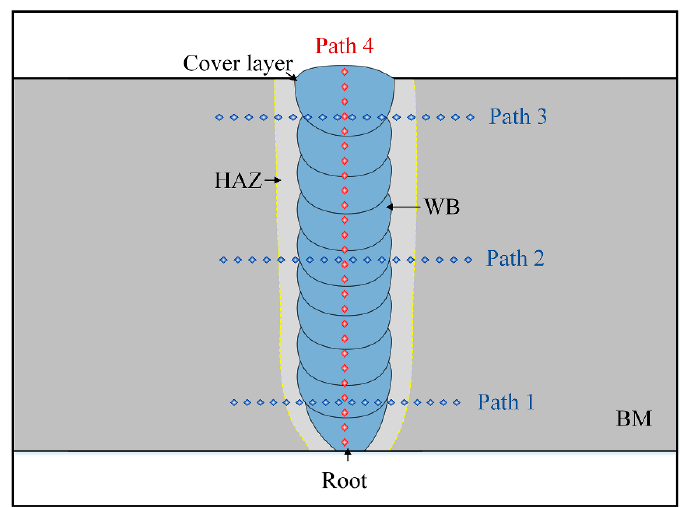
Figure 11. The Vickers hardness test path selection diagram.